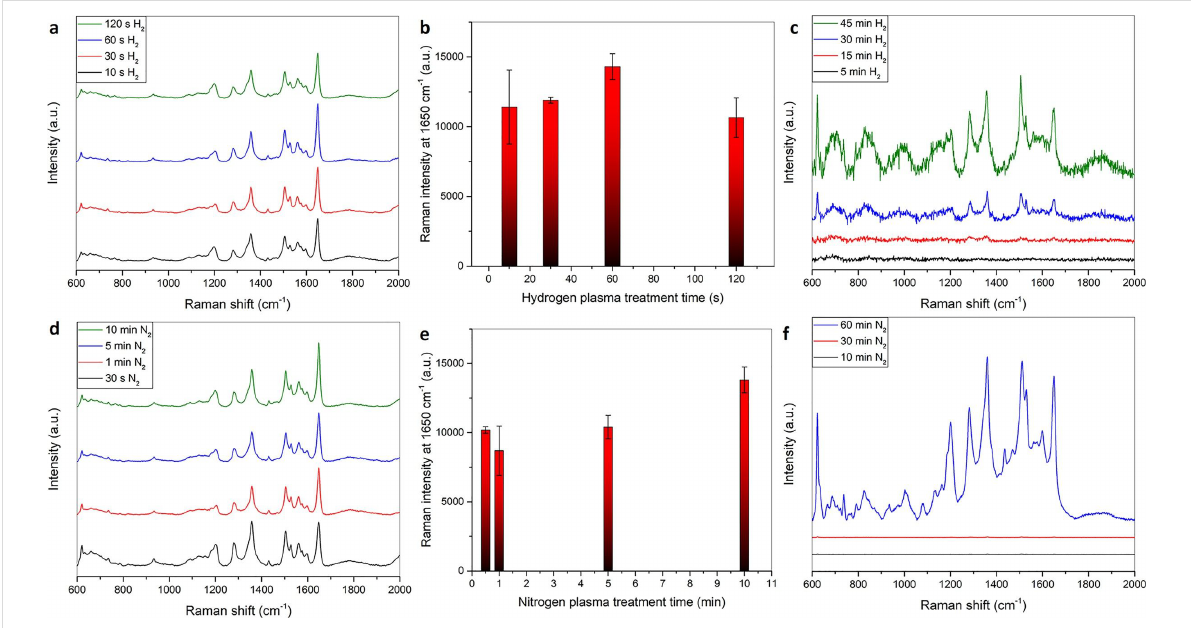
Figure 12: (a) SERS spectra of 10 − 6 M RhB deposited on a 10 nm silver film treated with hydrogen plasma (g12-p200) using a 514.5 nm laser. (b) Comparison of the average Raman intensities at 1650 cm − 1 . (c) SERS spectra of 10 − 6 M RhB on 200 nm Ag treated with hydrogen plasma (g12- p200) using a 632.8 nm laser. (d) SERS spectra of 10 − 6 M RhB on a 10 nm silver film treated with nitrogen plasma (g12-p200) using a 514.5 nm laser. (e) Comparison of the average Raman intensities at 1650 cm − 1 . (f) SERS spectra of 10 − 6 M RhB on a 200 nm silver flm treated with nitrogen plasma (g12-p200) using a 632.8 nm laser.